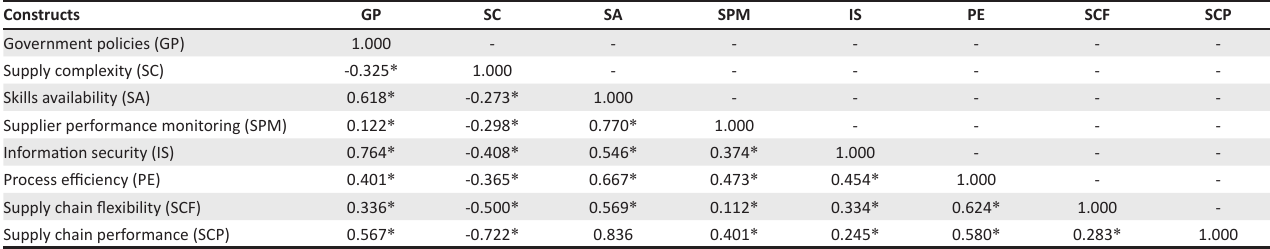
TABLE 4: Inter-factor correlations.